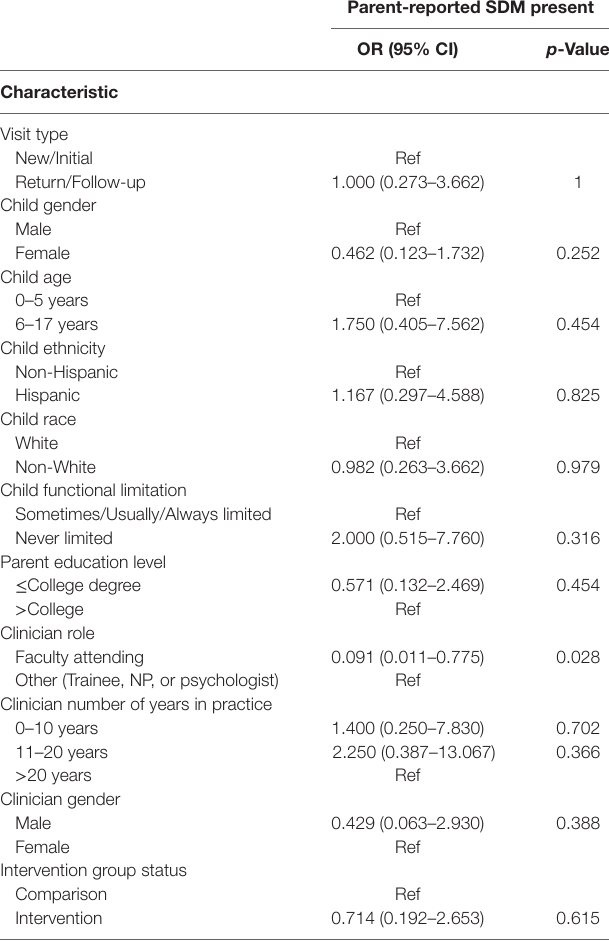
Parent-reported sDM